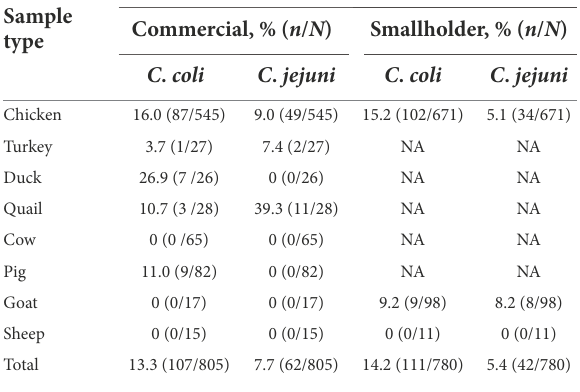
TABLE 2 The prevalence of C . coli and C . jejuni in commercial and smallholder farm animals.